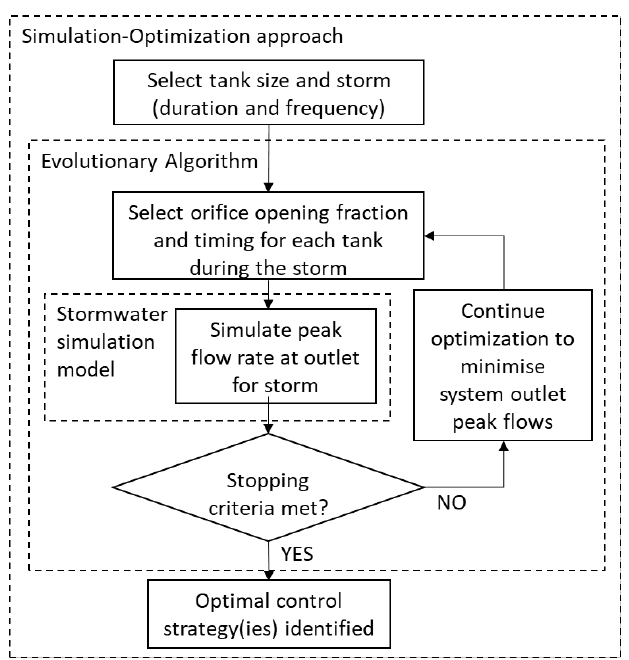
Figure 3. Details of the simulation-optimization approach used to identify tank outflow control strategies that minimize system peak outflows.